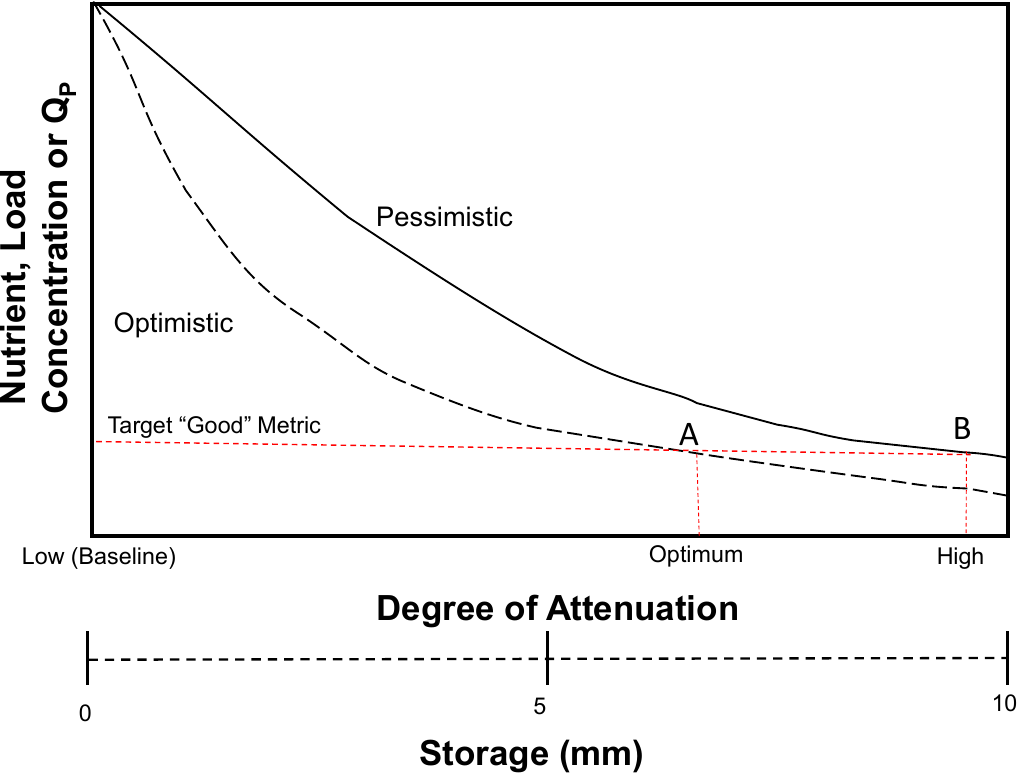
Figure 2. Sketch of relationship between load or concentration and degree of attenuation and storage (both plotted on the x -axis) in a hypothetical catchment indicating how adding storage can achieve a desired target.